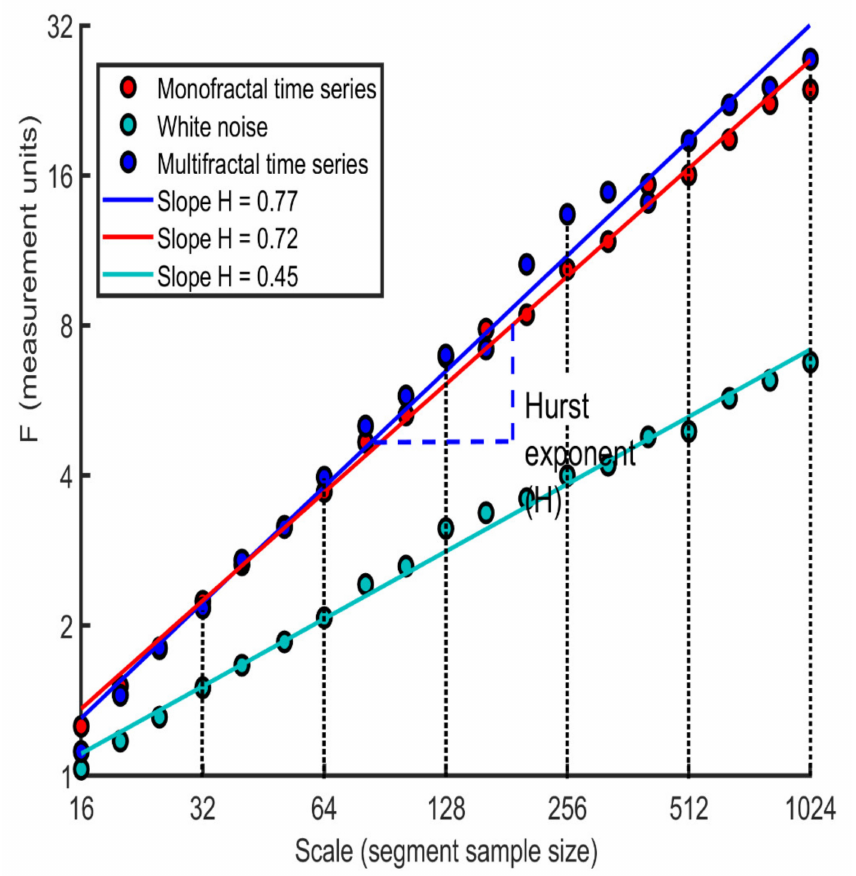
Figure 2. Hurst exponent variation for monofractal and multifractal series compared with white noise time